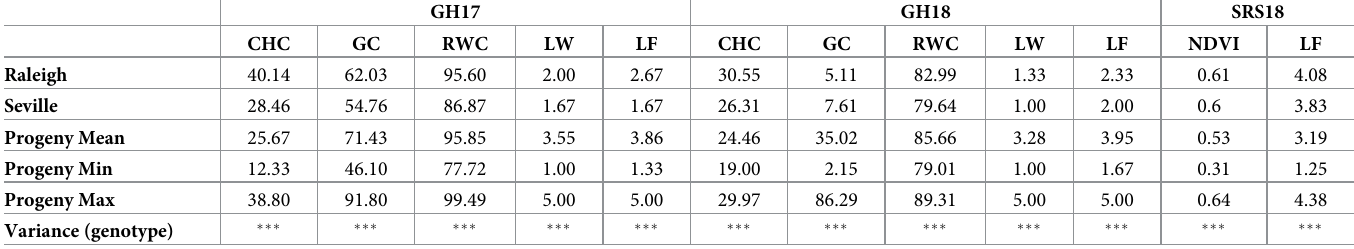
Table 1. Phenotypic data and genotype variance on chlorophyll content (CHC), percent green cover (GC), leaf relative water content (RWC), leaf wilting (LW), leaf firing (LF) and normalized difference vegetation index (NDVI) for a St. Augustinegrass Raleigh x Seville F 1 population evaluated for drought response under green- house (GH17 and GH18) and field conditions (SRS18).